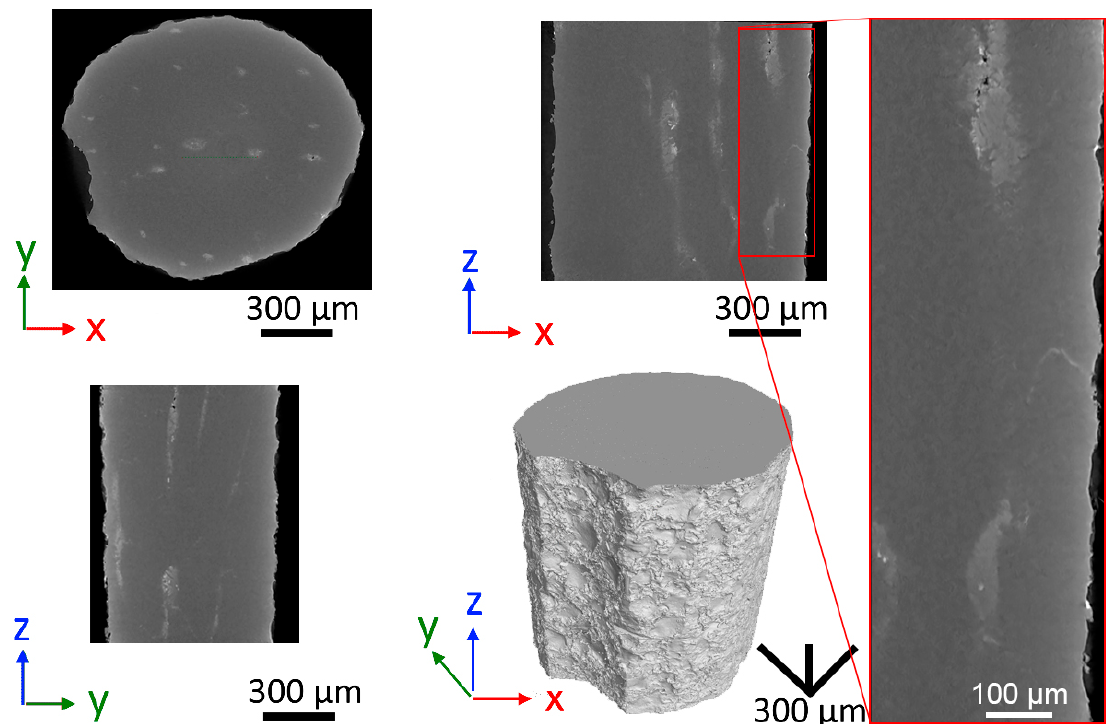
Figure 4. 3D representation of the as-cast specimen and three orthogonal slice images through a pore-rich area close to the border of the specimen.